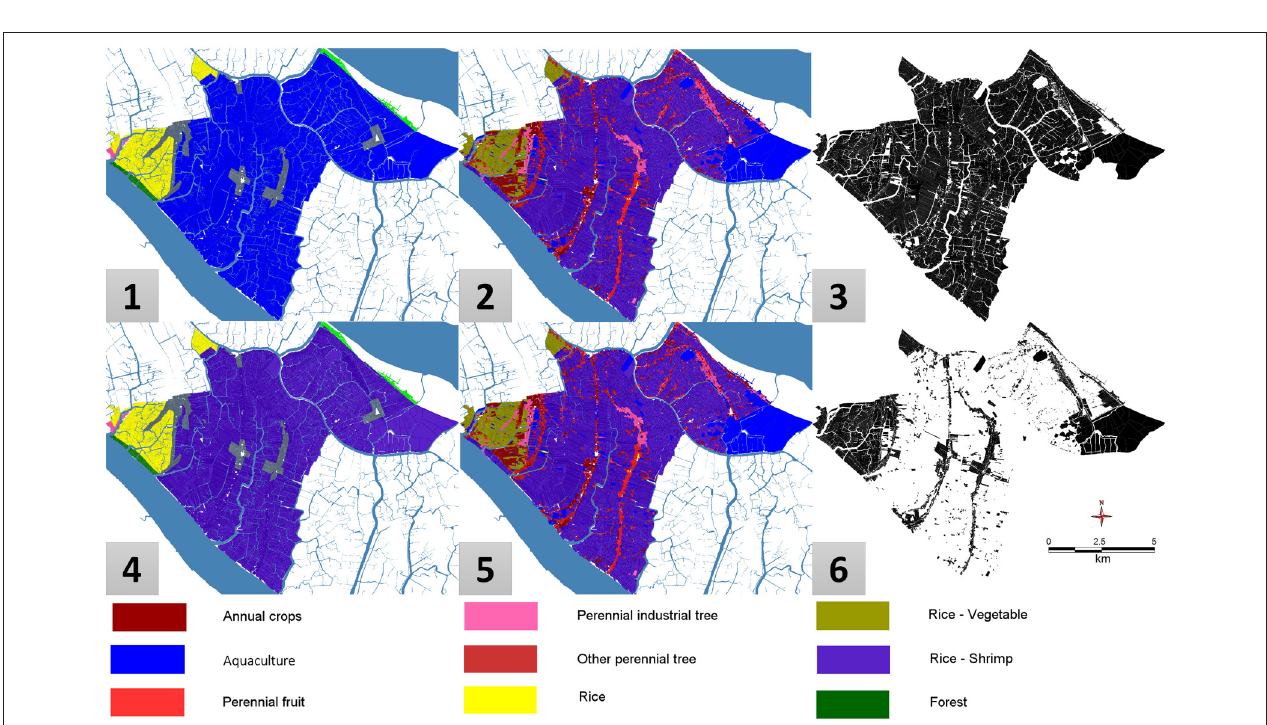
FIGURE 3 | Maps of the five villages of Thanh Phu district in the Mekong Delta. Source: Combined from the source of Land resource department, Can Tho University, Vietnam ( Vo and Le, 2006) and the Department of Environmental and Natural resources of Ben Tre province, Vietnam (PCBT, 2011).